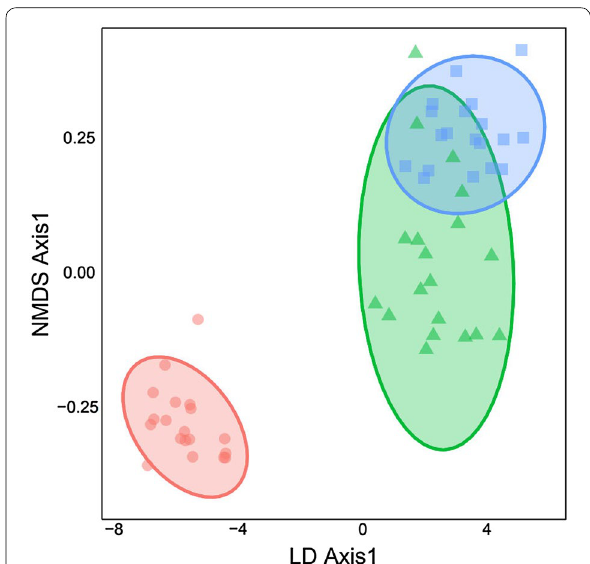
Fig. 10 Bivariate plot showing correspondence of phenotype (x‑axis) with genotype (y‑axis) for individuals from Kufranjah valley (northern population, blue squares), Dead Sea region (northern population, green triangles) and Wadi al Yutm (southern population, red circles). The linear discriminant (LD) axis is based on Euclidean distances of 14 morphological characteristics standardized to a mean of zero and standard deviation of one. The nonmetric multidimensional scaling (NMDS) axis is based on Jaccard’s pairwise distances between Inter‑Simple Sequence Repeats (ISSR) of